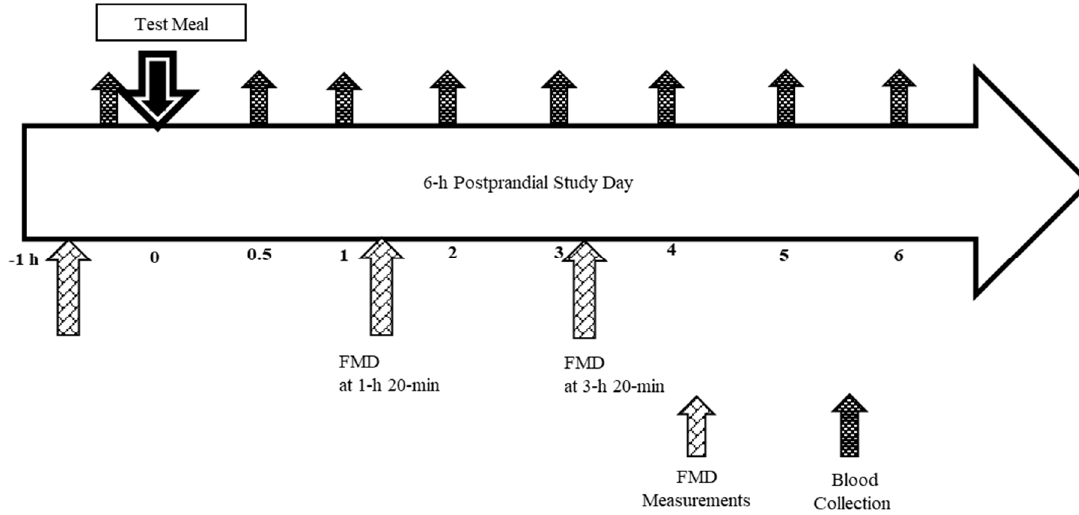
Figure 2. 6-h postprandial study day schema. FMD indicates flow mediated vasodilation.